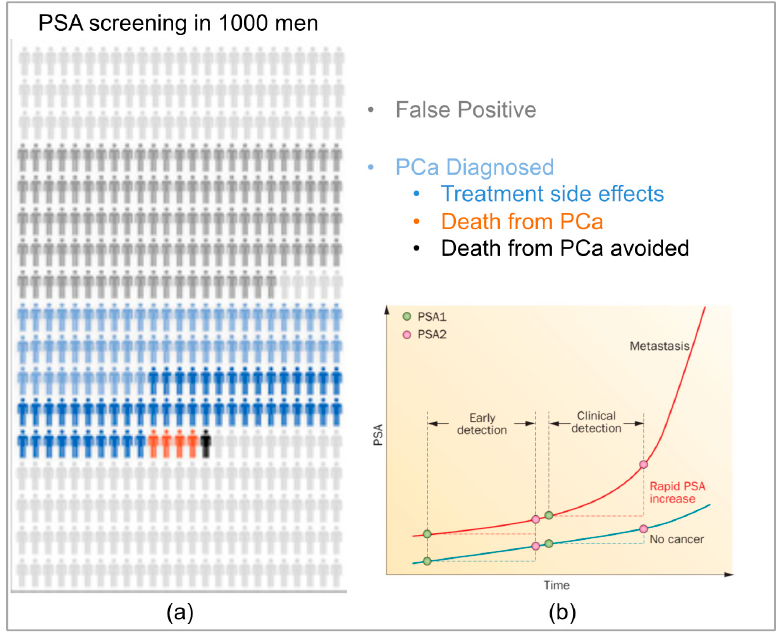
Figure 1. PSA screening and over diagnosis: The info graphic indicates the proportion of patients for which a true diagnosis versus of prostate cancer is achieved as result of PSA screening ( a );